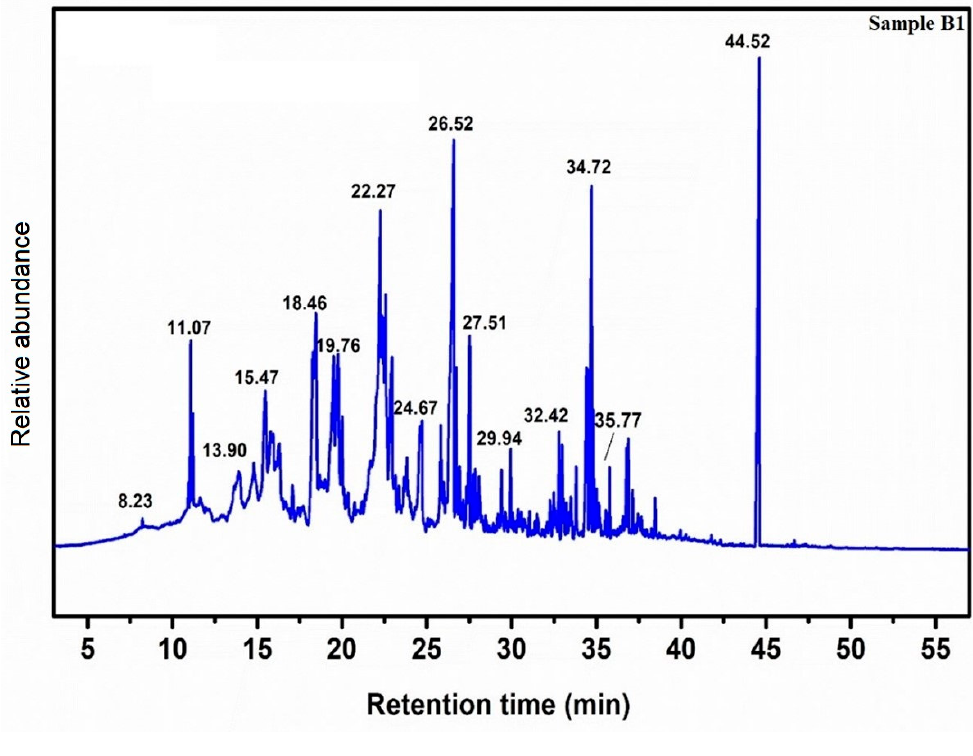
Figure 3. GC-MS analysis of sample B1.